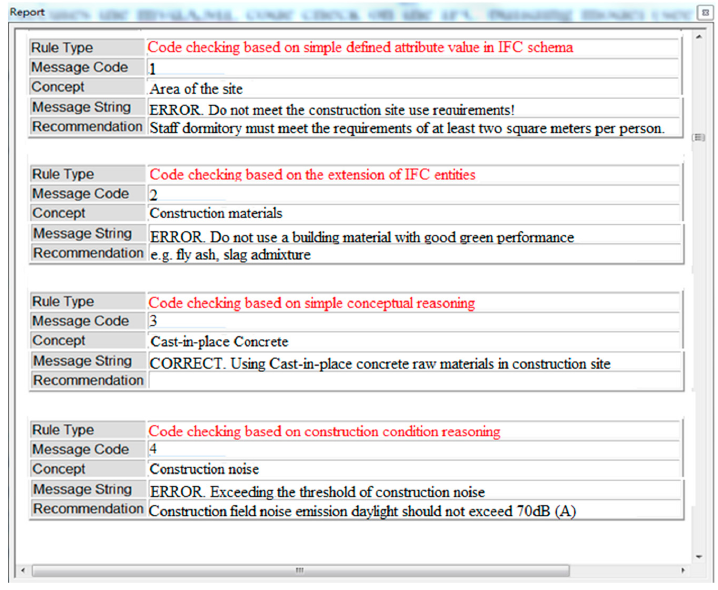
Figure 21. The HTML report of code checking.